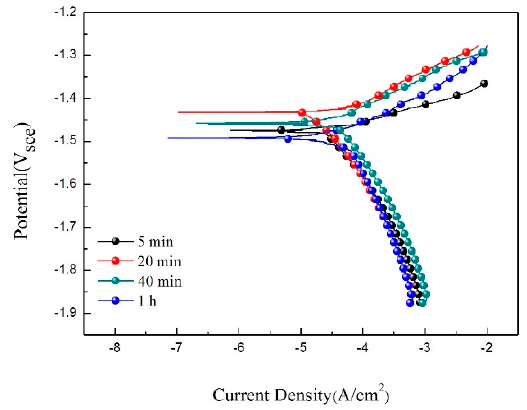
Figure 9. Potentiodynamic polarization curves of samples immersed in SBF solution for different time intervals. Table 3. Fitting results of the polarization curves.